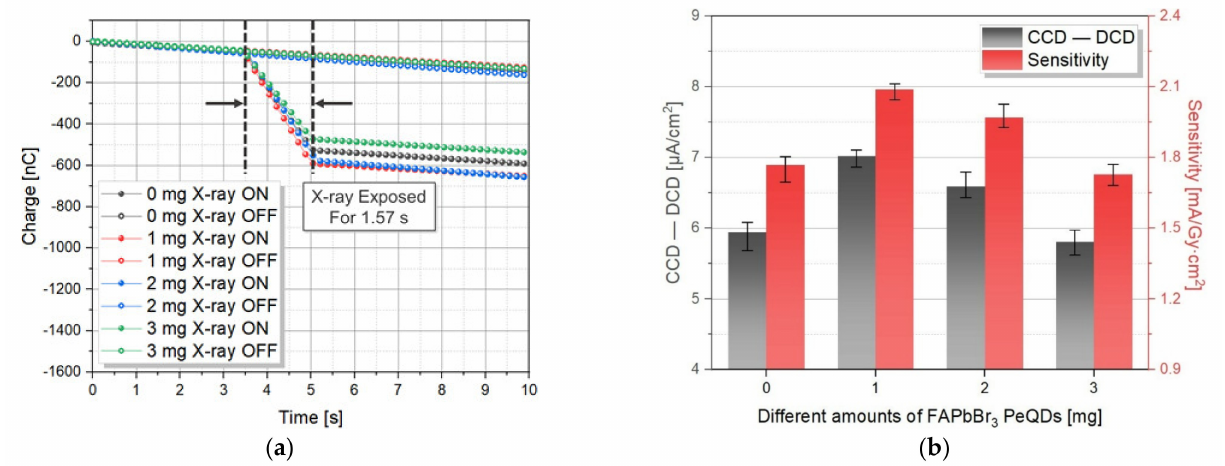
Figure 5. ( a ) C − S characteristic curve, and ( b ) radiation parameters (CCD—DCD and sensitivity) of the detectors based on the P3HT:PC 71 BM active layer with different amounts of FAPbBr 3